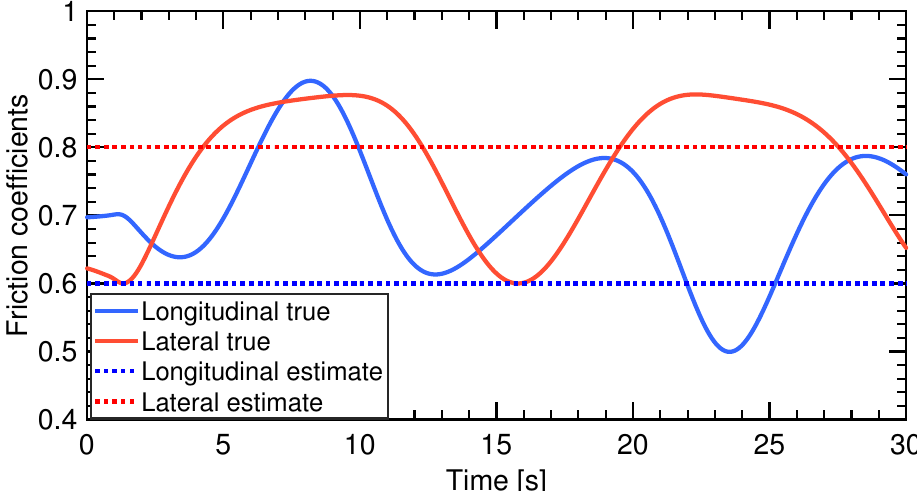
Figure 19. Friction coefficients values on the vehicle path (circular